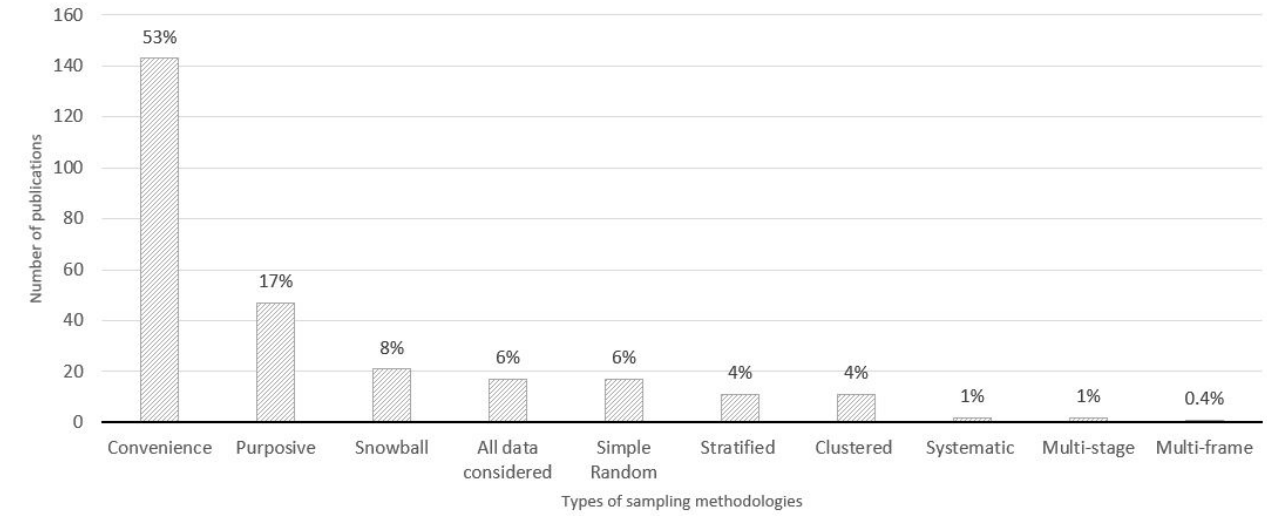
Figure 11. Types of sampling methodologies used in the studies examined ( n = 272).